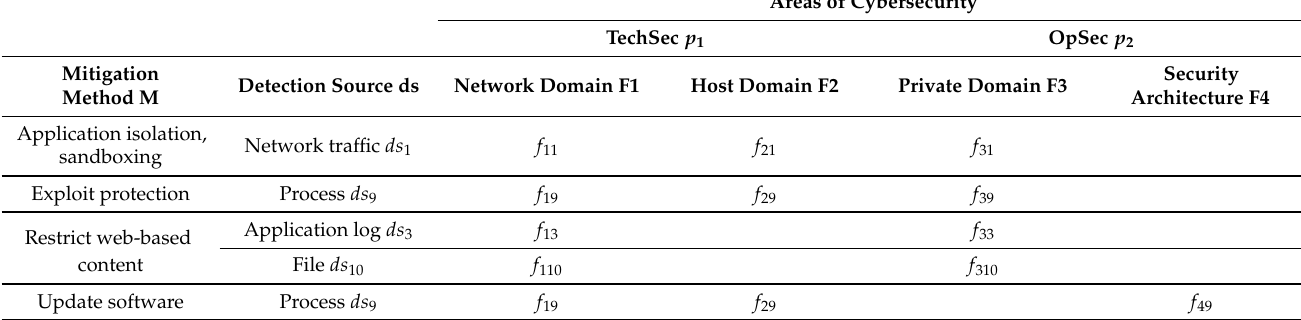
Table 3. Stage 3: